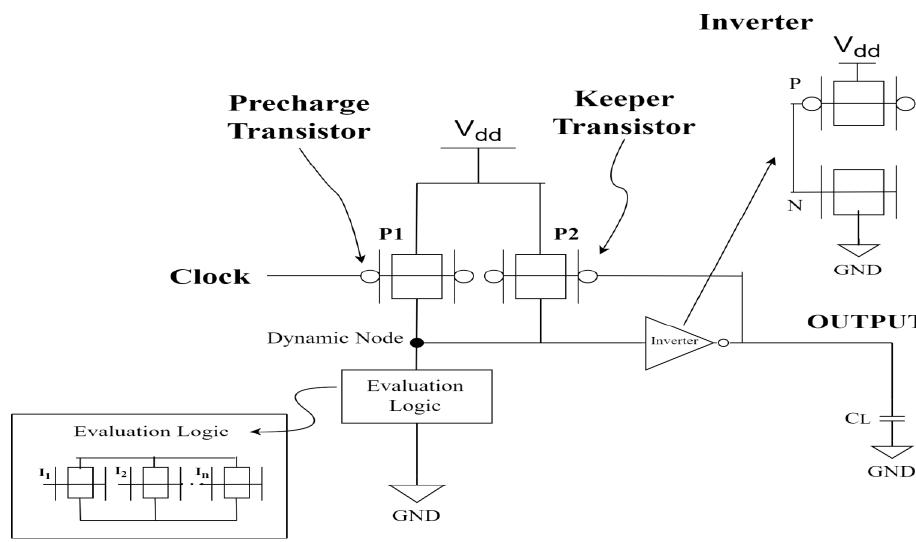
Figure 5. Domino logic without foot (DLWF) [26].